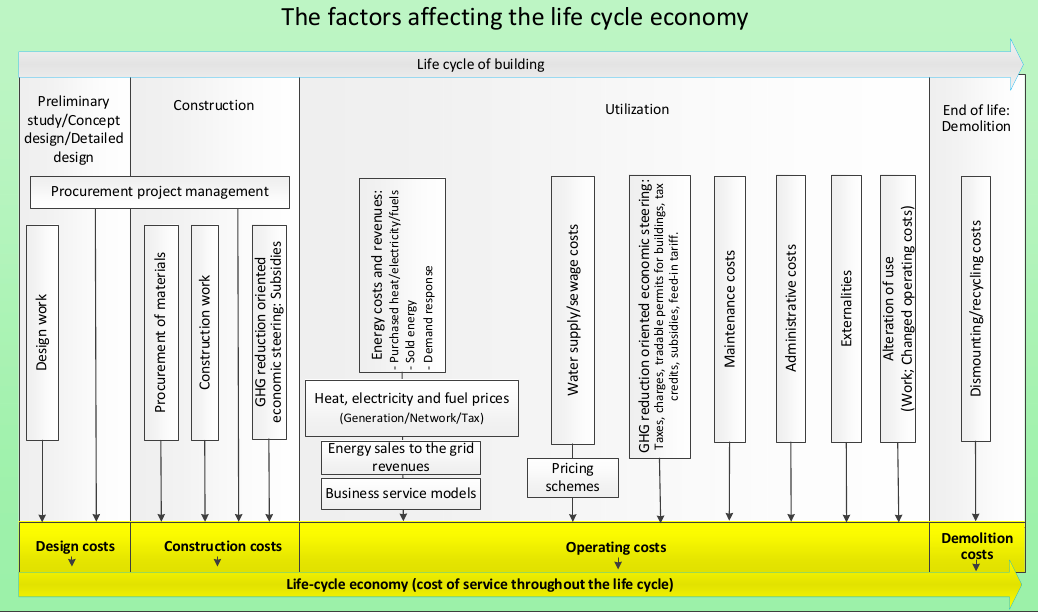
Figure 6. The identification of factors affecting the life cycle economy of a building. GHG: greenhouse gas.